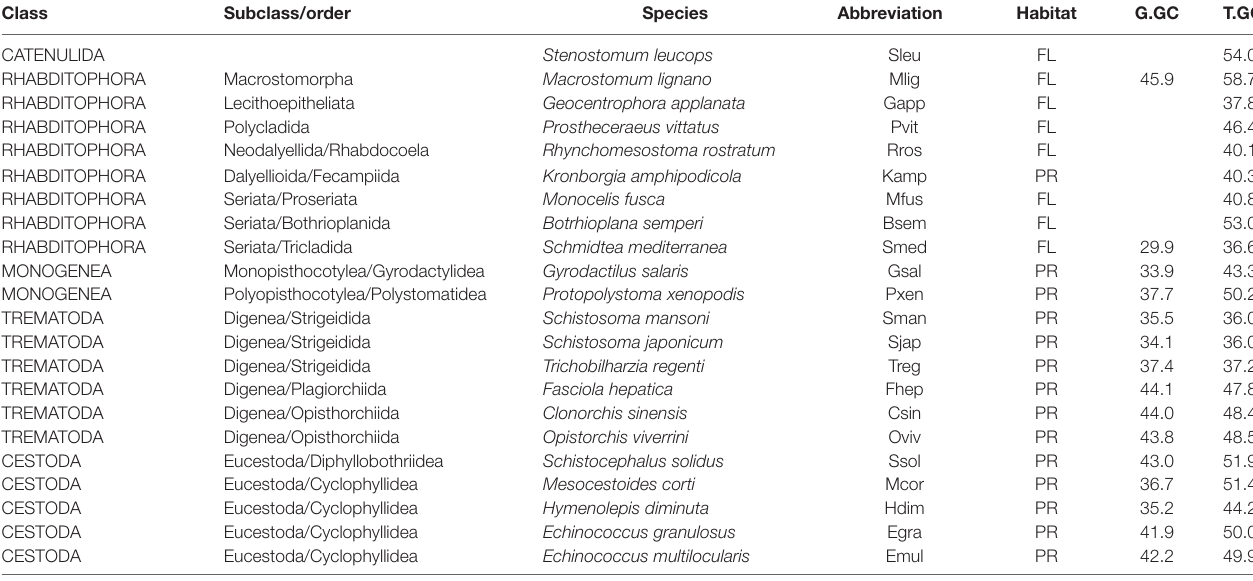
TABLE 1 | List of species analyzed and their GC content.FL, Free-living; PR, parasitic; G.GC, genomic GC percentage; T.GC, transcript (CDS) GC percentage.